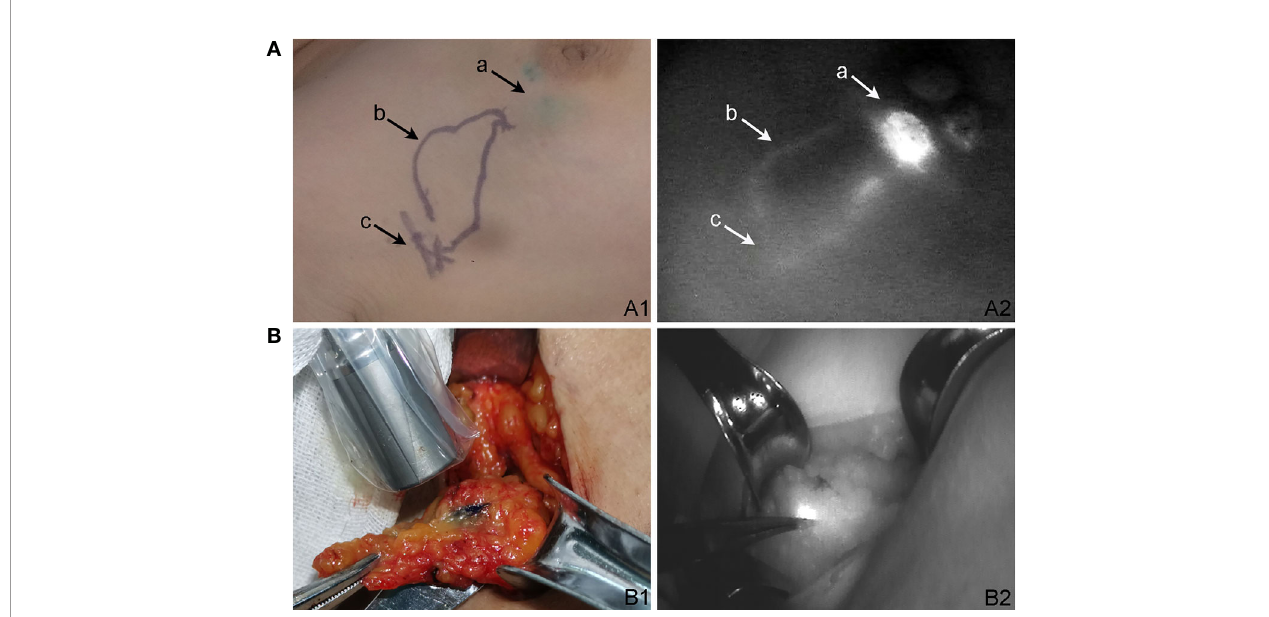
FIGURE 2 | Detection of tracer-positive lymph node. (A) ICG skin development. (A1) ICG percutaneous lymphography and sentinel lymph node localization. (A2) Lymphatic pathway under the fl uorescent detector. (a) ICG injection location. (b) Lymphatic vessels highlighted by ICG. (c) Sentinel lymph node location. (B) The development of sentinel lymph nodes after subcutaneous incision. (B1) Blue-stained lymph node was detected by the g detector. (B2) The same lymph node was ICG positive under the fl uorescent